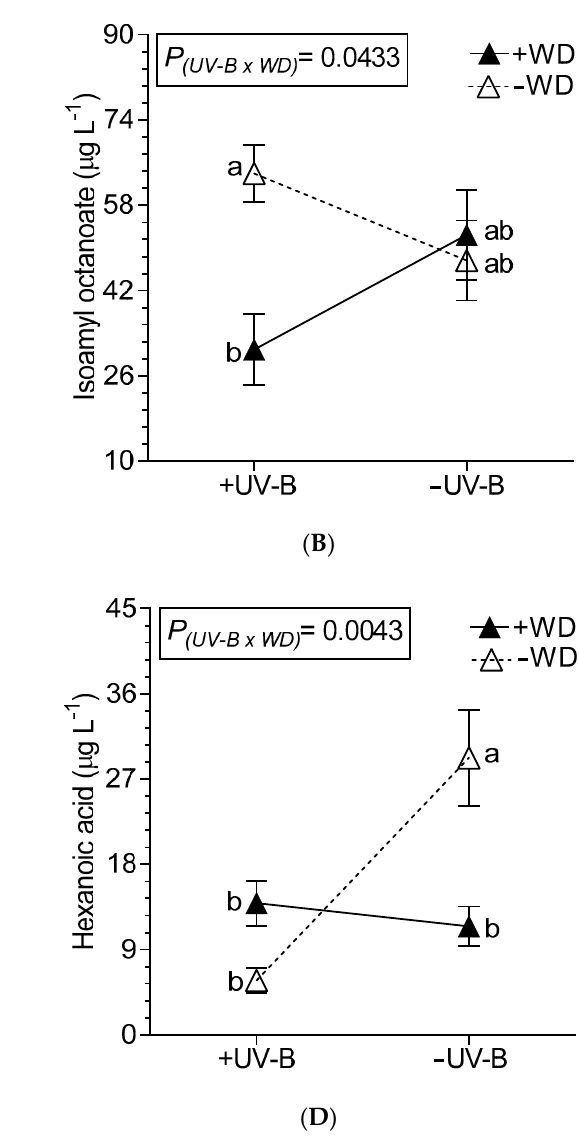
Figure 4. Interaction between UV-B and WD for ethyl lactate ( A ), isoamyl octanoate ( B ), ethyl succinate ( C ) and hexanoic acid ( D ), determined in wines from Malbec plants exposed to combined UV-B, WD and ABA treatments. Values are means for each factor combination ±SEM (n = 3) and different letters indicate significant differences (Fisher’s LSD, p ≤ 0.05).